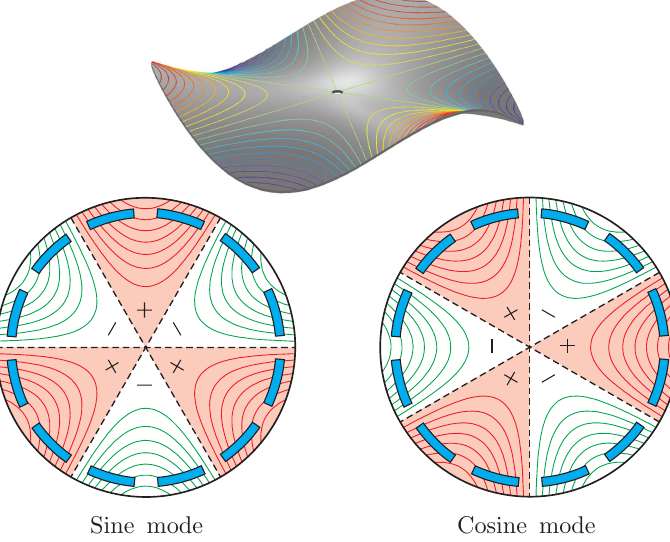
Figure 2. Disk vibrating in the mode n = 3, s = 0, equipped with 12 piezoceramic (PZT) patches regularly spaced on the